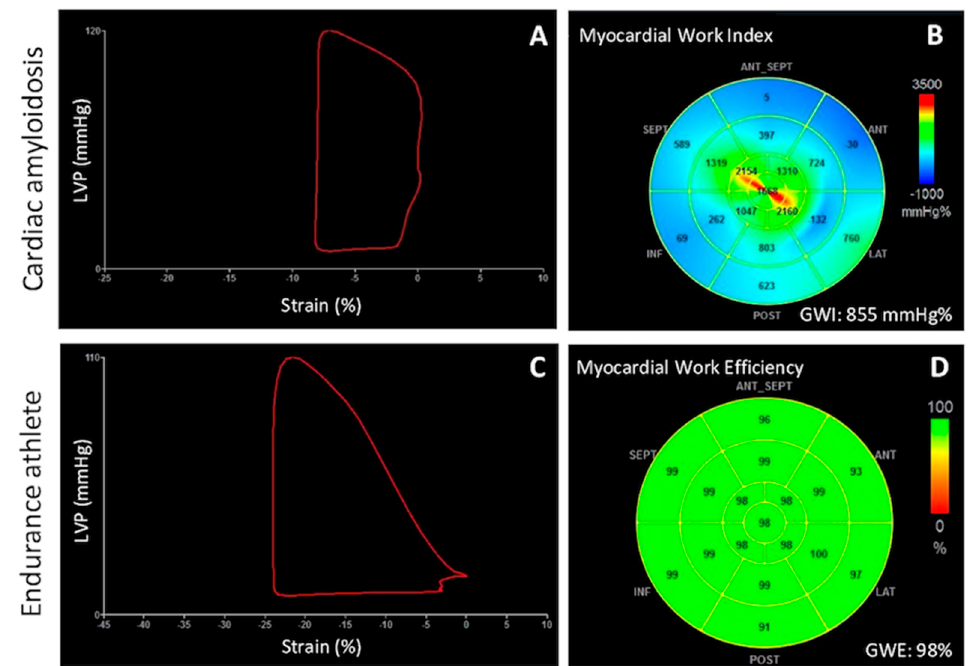
Figure 3. Pressure-strain loop ( A ) and 17-segment bull’s-eye representation of GWI ( B ) in a patient with cardiac amyloidosis, showing a reduced loop area, representing a reduced stroke work developed by the ventricle, and significant impairment of MW index in the basal segments. In endurance athletes MWE is an early predictor of physiologic remodeling in baseline examination ( C , D ). GWI = global work index; GWE = global work efficiency; LVP = left ventricular pressure .